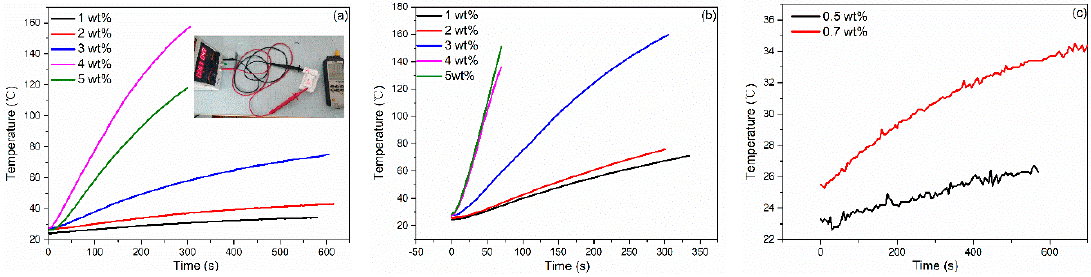
Figure 8. Self-heating performance of CGCB. Heating voltage is 5V ( a ), 10V ( b ), and 30V ( c ).